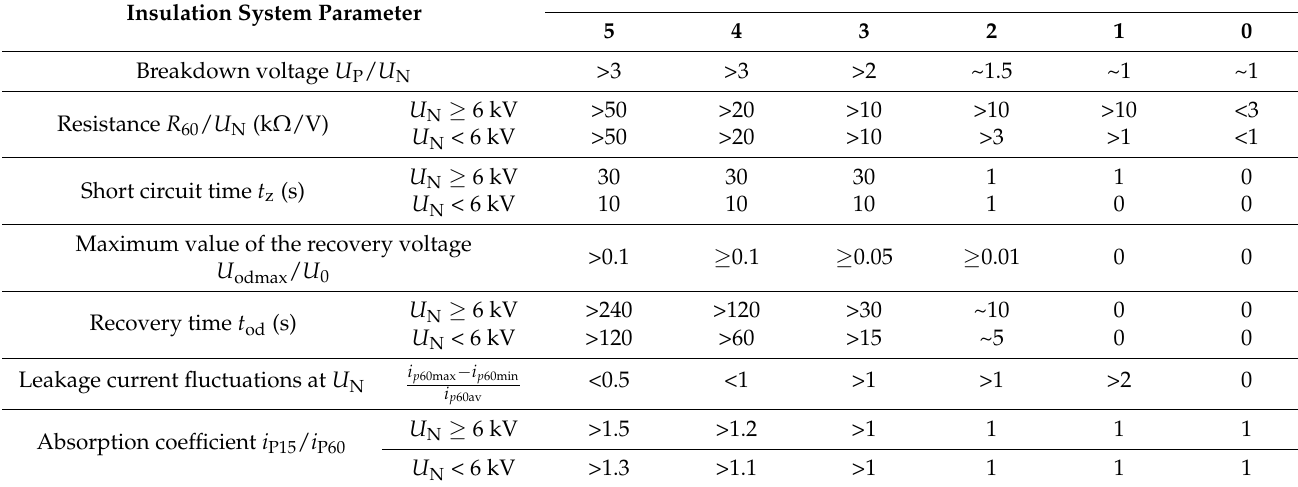
Table 7. Criteria for the assessment of the technical condition of insulation on the basis of the WMPS method.